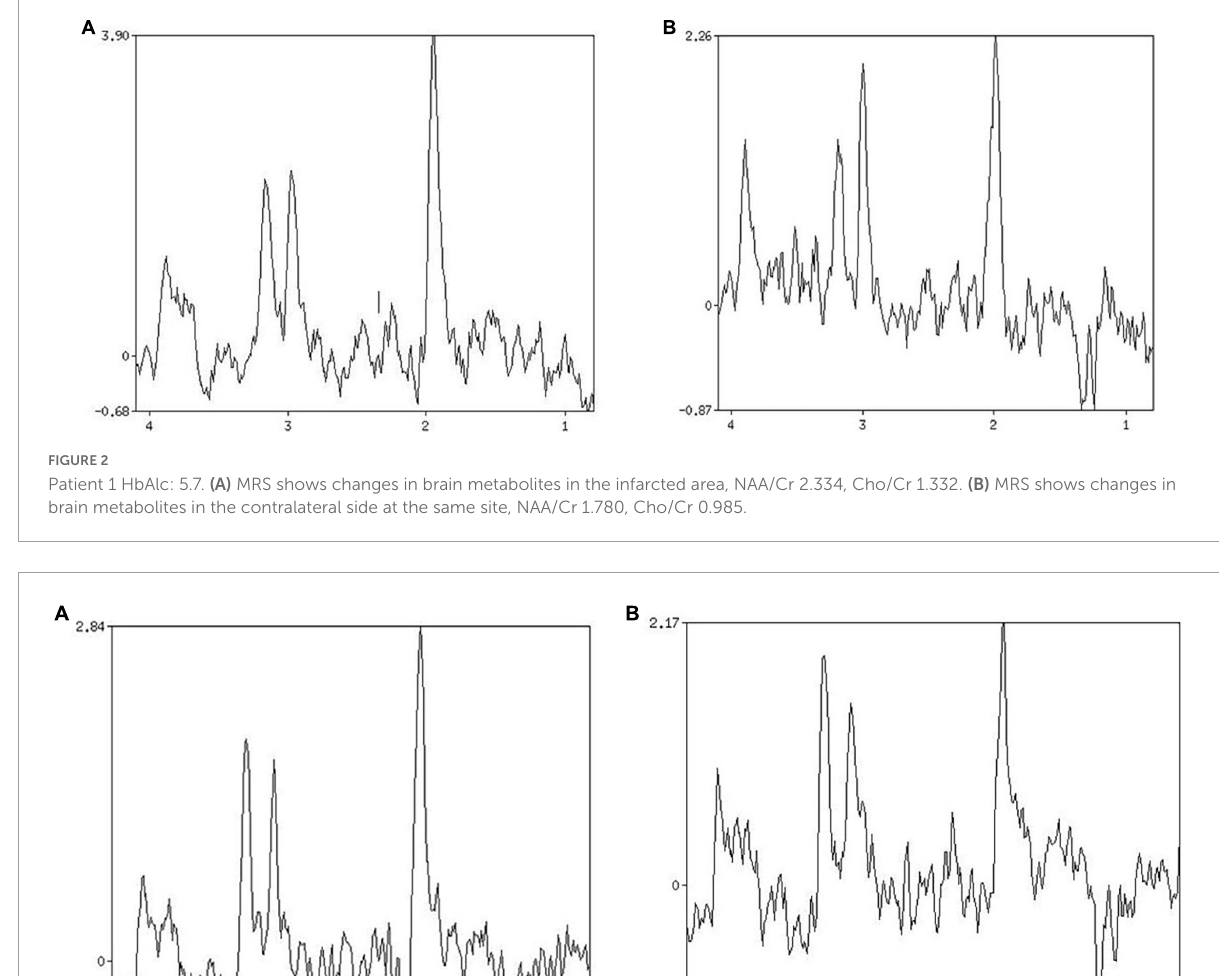
value of the poor glycemic control group was lower than that of the good glycemic control group, which further indicates that the blood sugar elevation aggravates the nerve fiber damage